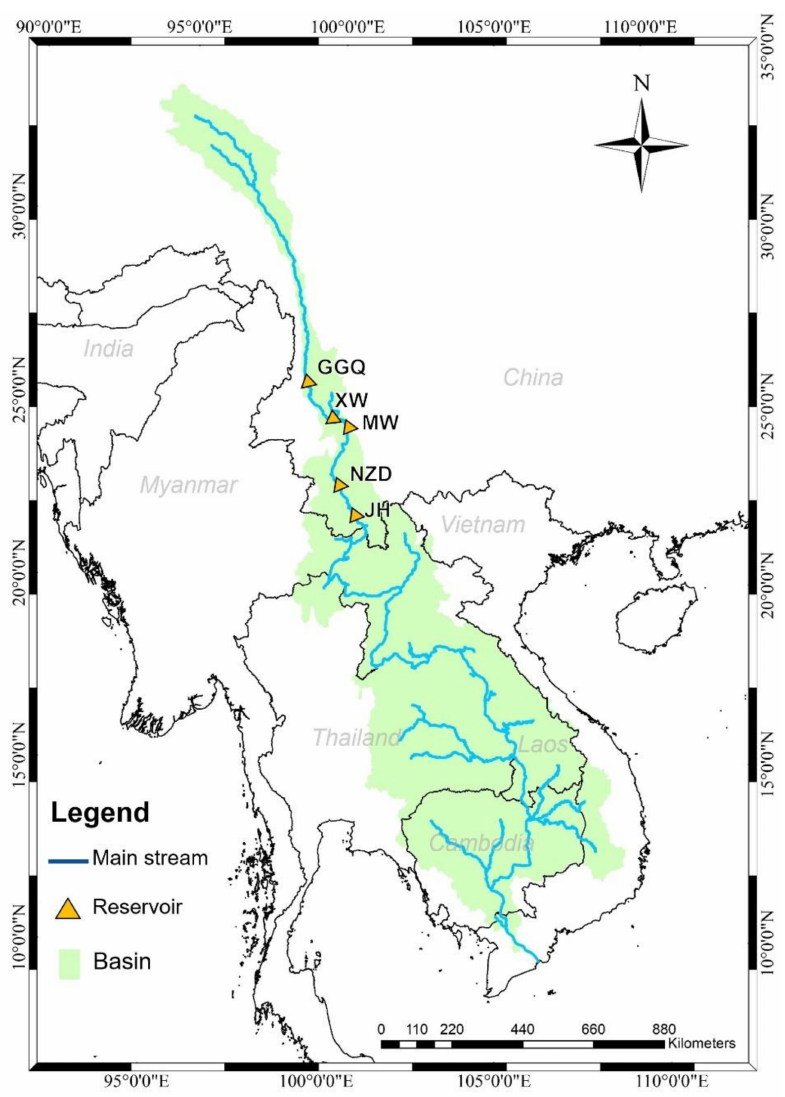
Figure 1. Overview of Lancang-Mekong River